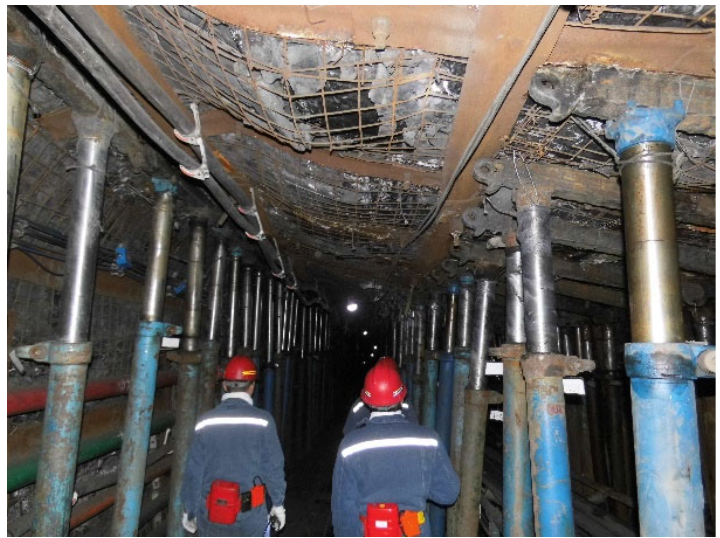
( b ) Figure 2. The 1304 working face return air roadway single hydraulic prop advance support diagram. ( a ) The 1304 working face return airway roadway support section diagram; ( b ) The 1304 working face return airway roof support top view. 2.3.2. Effect and Analysis of Original Support